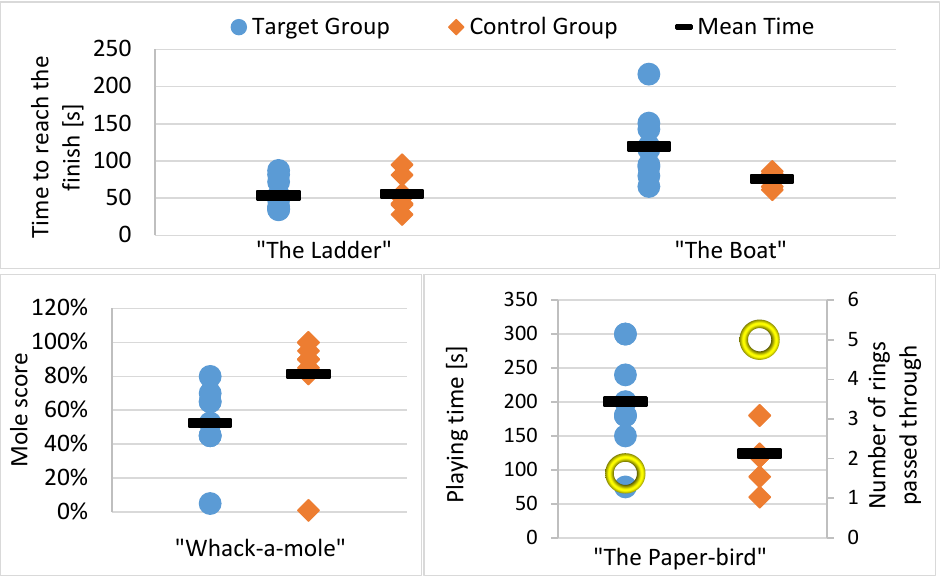
Figure 7. Results obtained for the four tested mini-games.